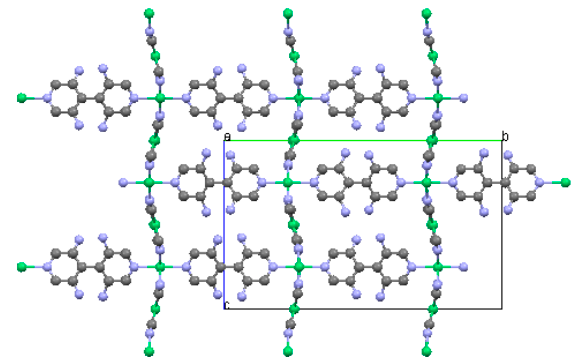
Figure. 14. Figure 14. 2-D Ni(CN) 4 wavy net connecting to each other via the Ni-BPyNH2 ligands to form a 3-D structure (C-grey, N-blue, Ni-green), viewing along a -axis.